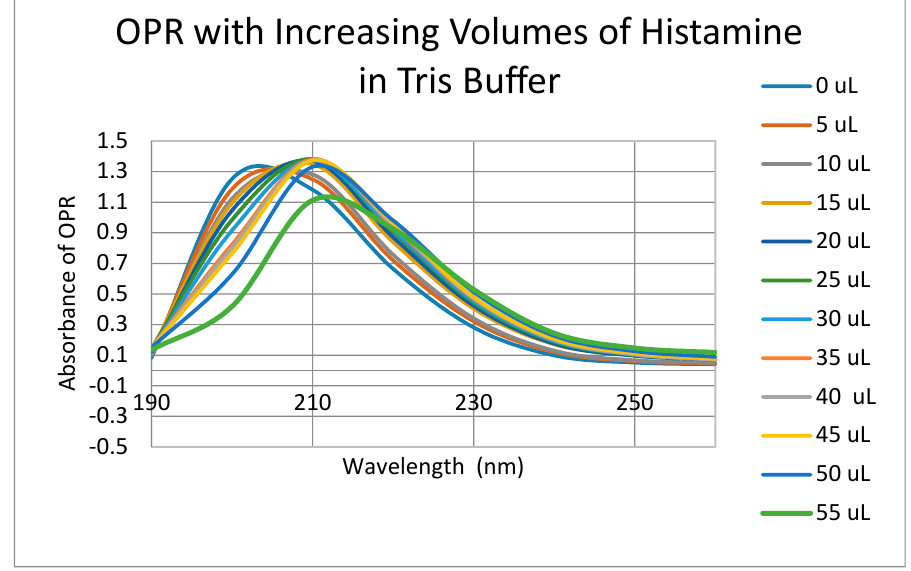
Figure 11. UV spectra of mu opioid receptor (OPR) with serial additions of histamine in Tris buffer as in Figure 10. No significant binding was observed for histamine or for acetylcholine (Table 3) or ascorbic acid (Table 3).